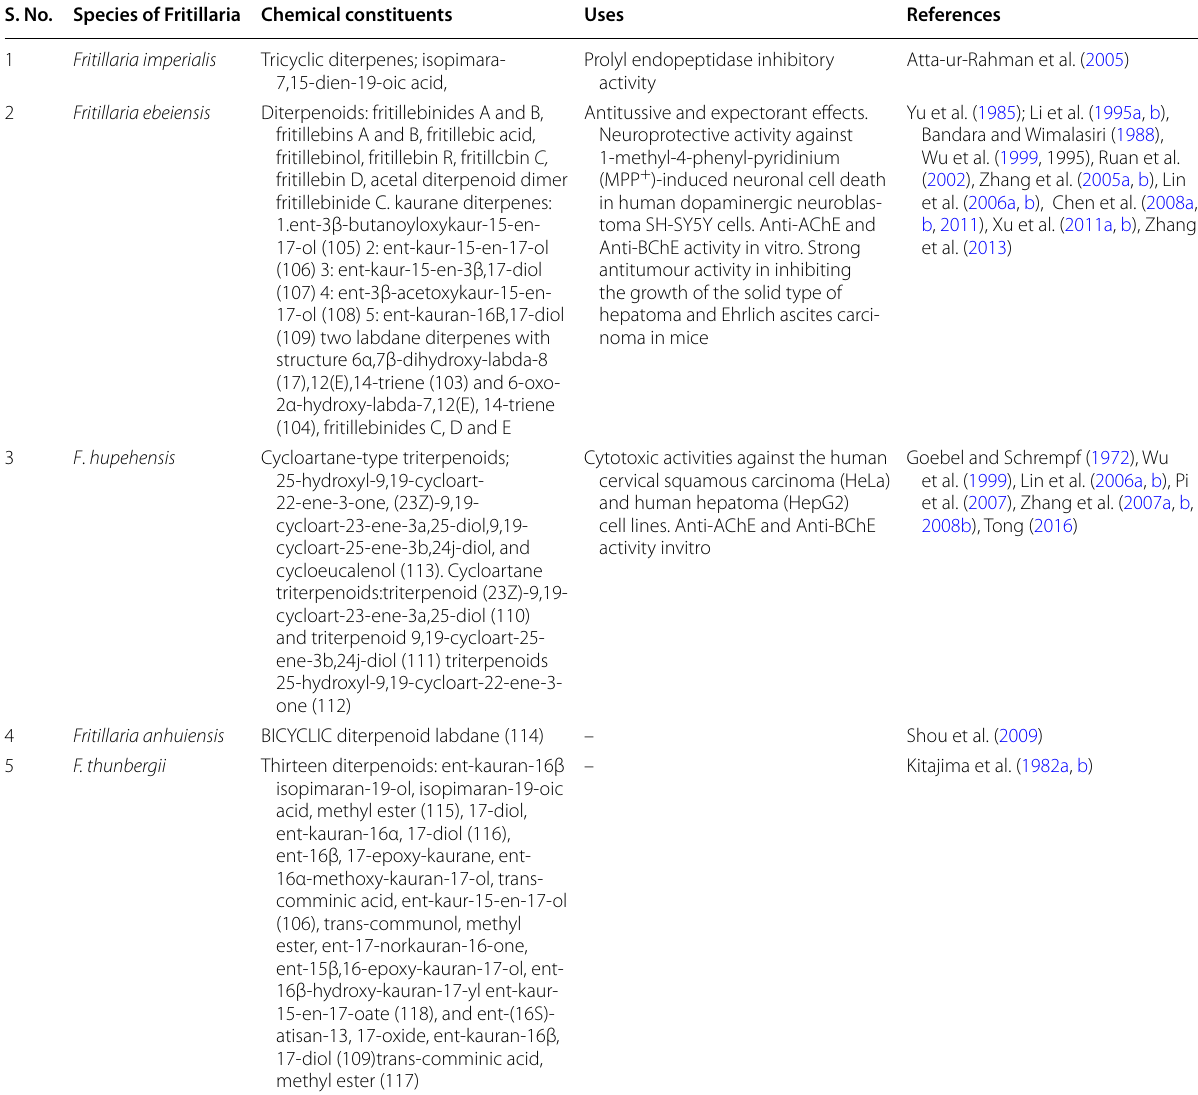
Table 3 Various terpenoids in genus Fritillaria and their uses